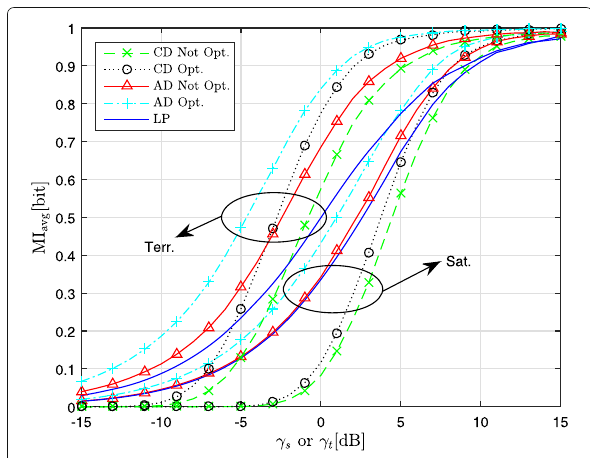
Fig. 5 Performance of CD, AD and LP for 2-PAM on terrestrial and satellite channel